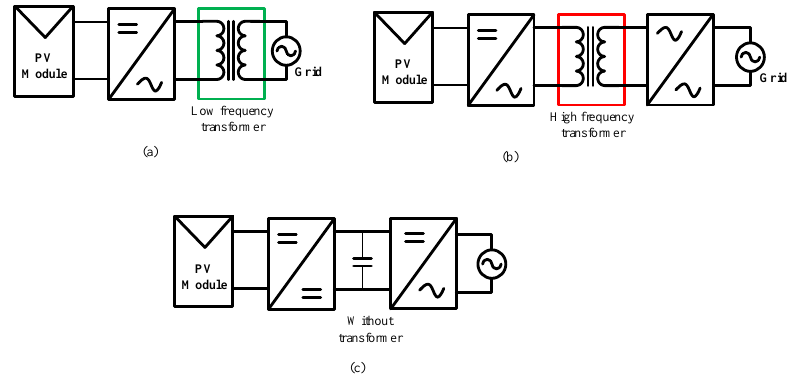
Figure 22. H-Bridge based PV inverter with: ( a ) low-frequency transformer, ( b ) high-frequency